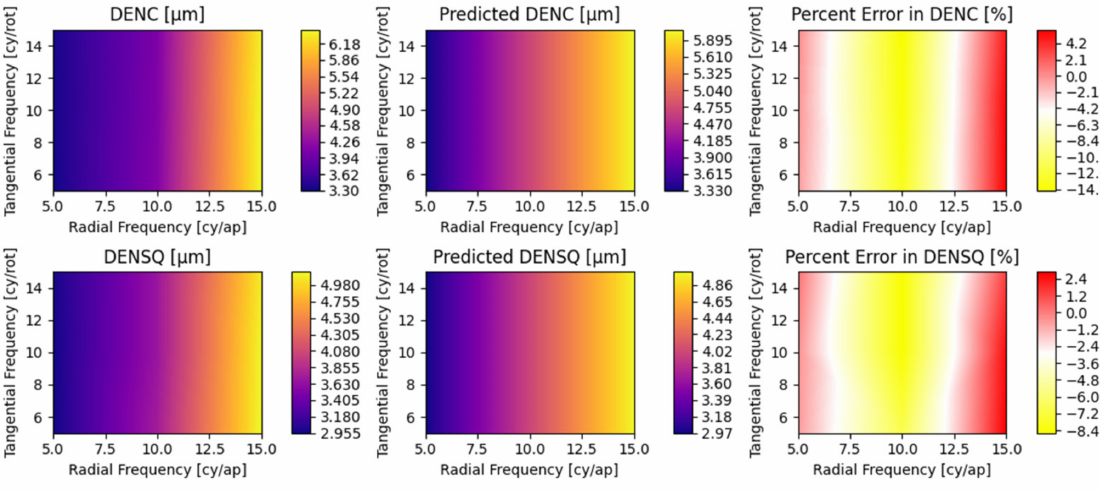
Figure A10. Radial Frequency versus tangential frequency. ( η = ζ = δ = 0, κ = 0.15, σ = 0.05, θ = 15 ◦